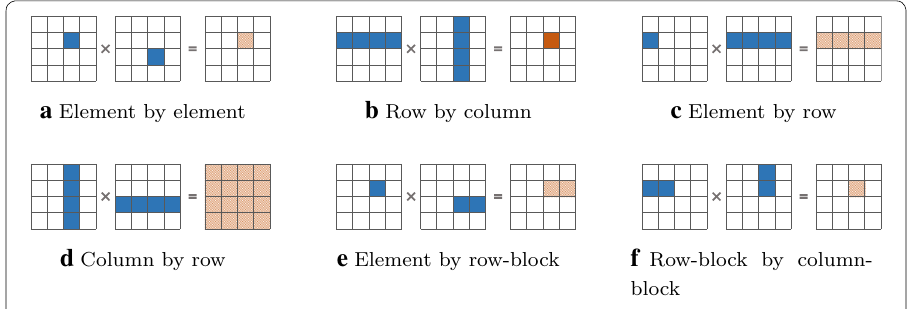
Fig. 2 Schemes of different strategies for matrix